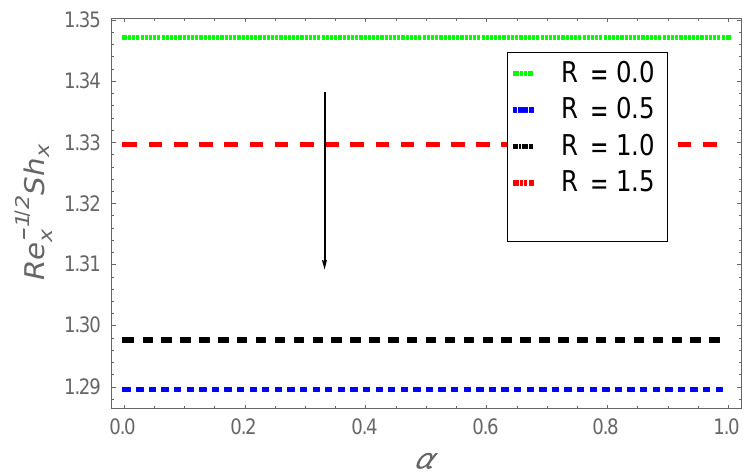
0.5 0.5 Re via and R  . Figure 34. Consequence of Re x Sh x via α and R